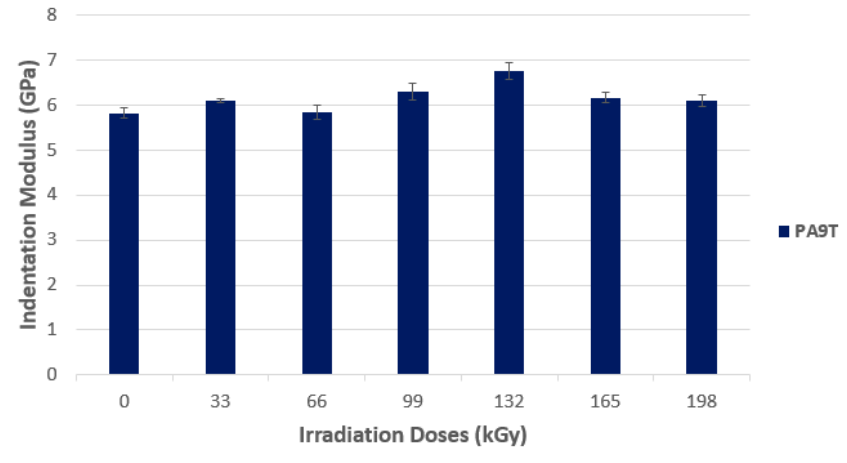
Figure 20. Indentation modulus ( E IT )—High-performance polymers.